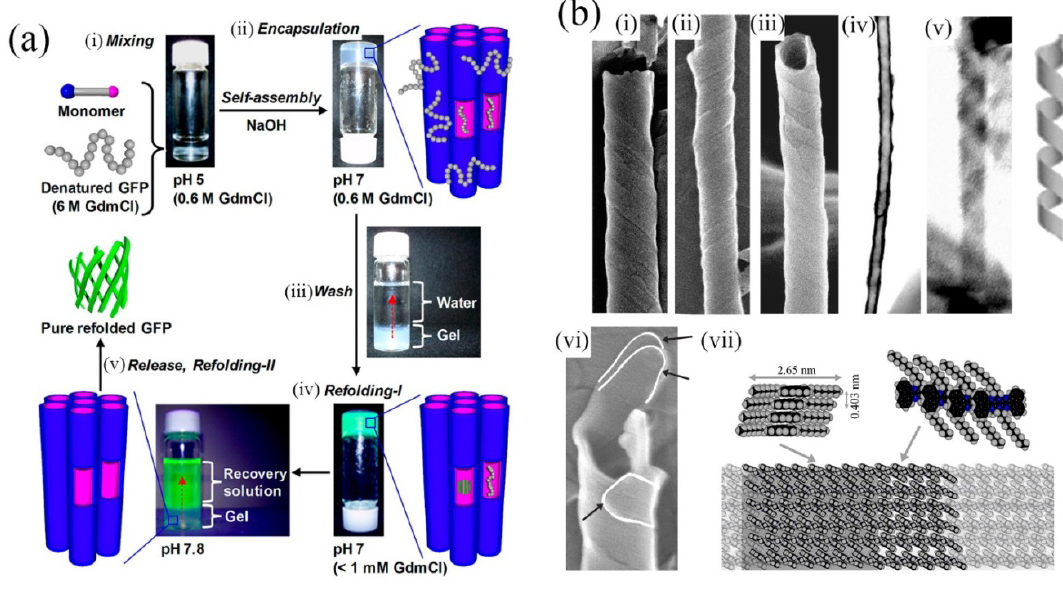
Figure 4. ( a ) Soft nanotube hydrogels: refolding procedure of a denatured protein (green fluorescence protein, GFP). (i,ii) Nanotubes undergo self-assembly concurrently with protein encapsulation. (iii,iv) Protein refolding occurs and highly fluorescent GFP is released by increasing pH (v). Adapted from ref. [23]. Copyright (2012) American Chemical Society; ( b ) (i)–(iii) SEM images of helically coiled tapes. (iv) STEM image showing internal cavity and exterior unevenness of the tubes. (v) An uncoiled helix. Just adjacent is a model of helically-coiled tape. (vi) Evidence for multi-walled tubes. White lines indicate the ends of three tapes composing this tube. (vii) Proposed model of the molecular level packing of the assembled molecules. Single-headed arrows indicate the respective viewing directions for the two structures given. ( b ) Reproduced from ref. [37] with permission from the PCCP owner societies. Copyright (2012) Royal Society of